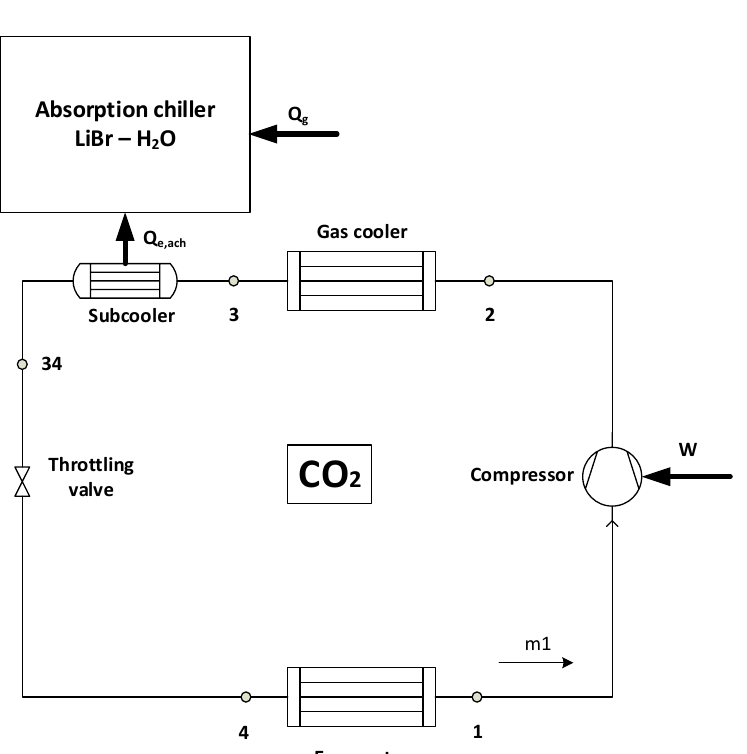
Figure 3. System with dedicated subcooling using an absorption chiller (ACH-SC). The quantity (Q e,ach ) is the subcooling heat rate which is equal to the refrigeration load of the absorption chiller.